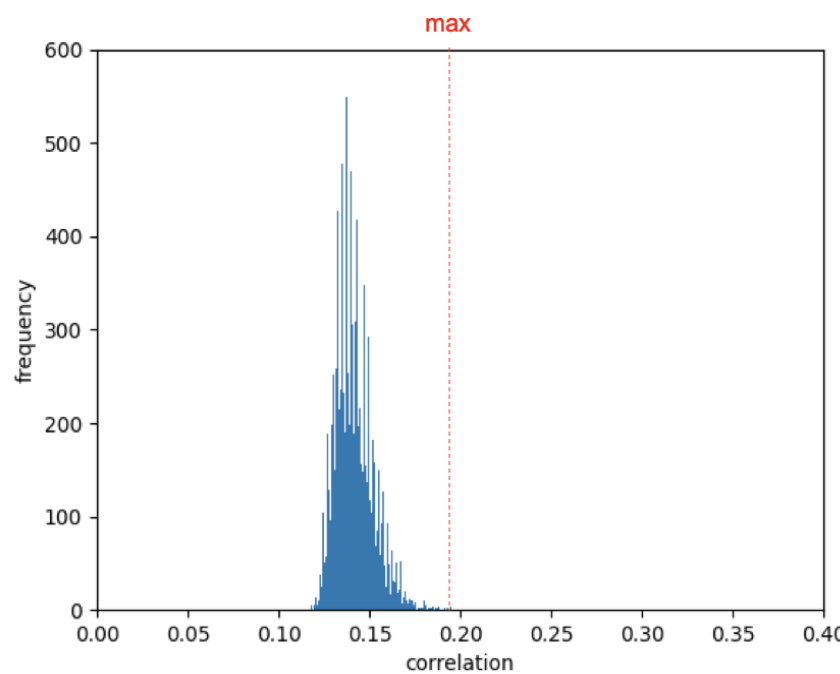
Figure 4. Comparison of correlation in each